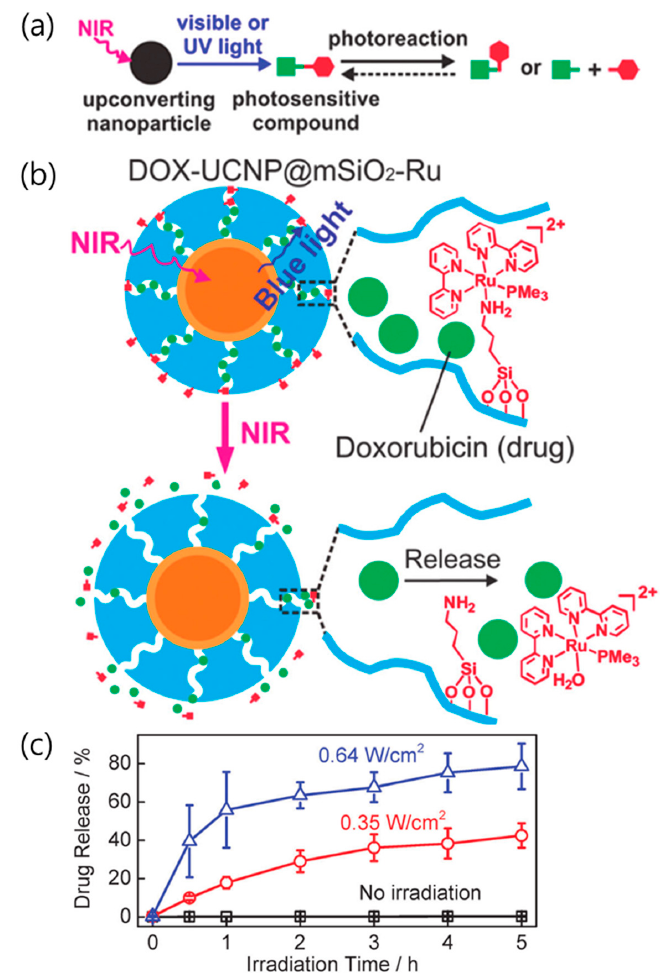
Figure 3. ( a ) Schematic illustration of photoreactions involving photosensitive compounds induced by UV and visible light produced by upconverted NIR radiation. ( b ) Under NIR irradiation, upconverted blue light triggers cleavage of the Ru complexes and drug release. ( c ) Doxorubicin release profiles with laser power and irradiation time. Reproduced with permission from [70]. Copyright The Royal Society of Chemistry,